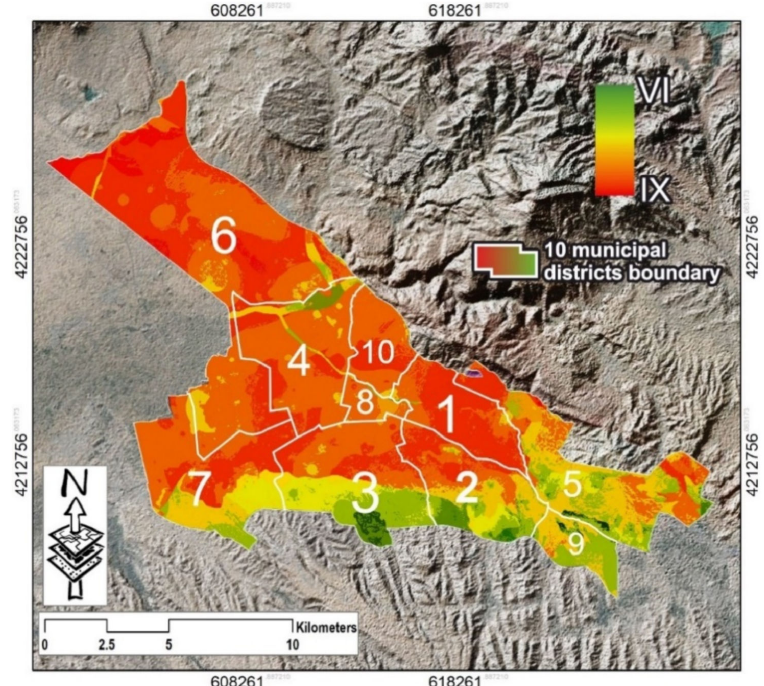
Figure 20. Ground shaking map illustrating the regional extent of the intensity that can be expected from a magnitude 7.3 (1721) earthquake on the North Tabriz